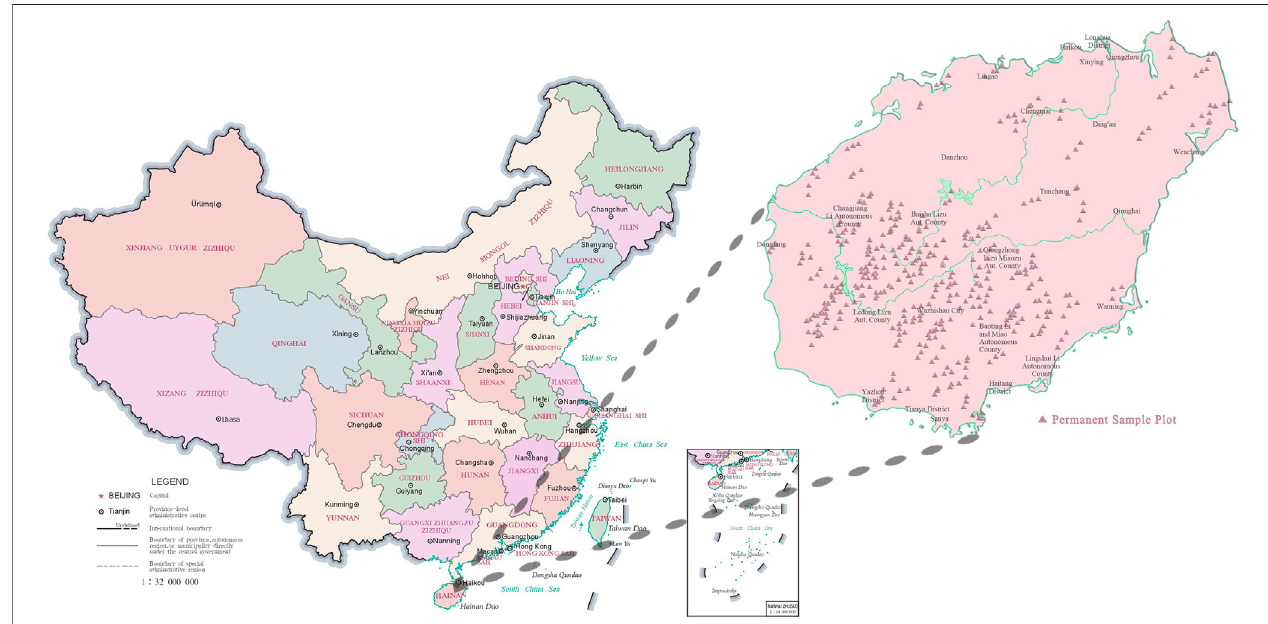
FIGURE 3 | Distribution of the forest permanent sample plots in Hainan Island.